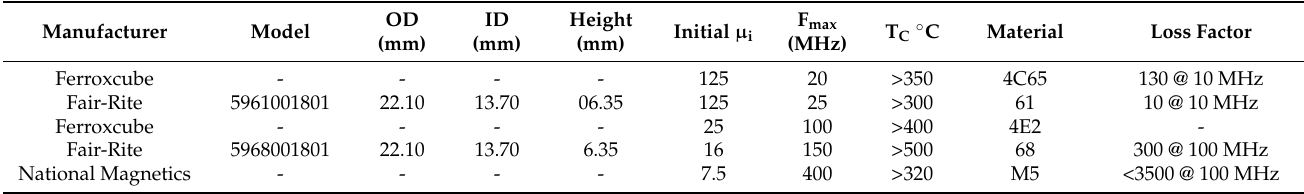
Table 2. Properties of a selection of ferrite materials and toroids.